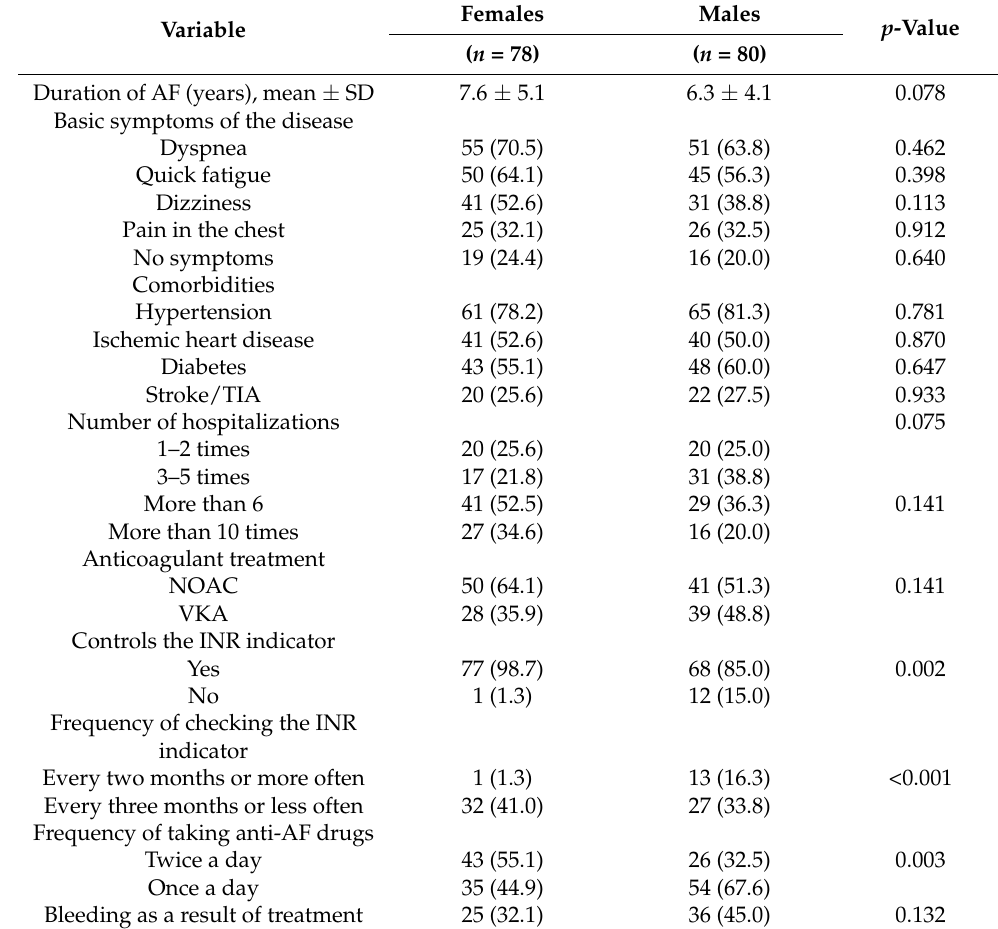
Table 2. Basic statistics for clinical parameters characterizing the population of 158 patients with atrial fibrillation (AF).